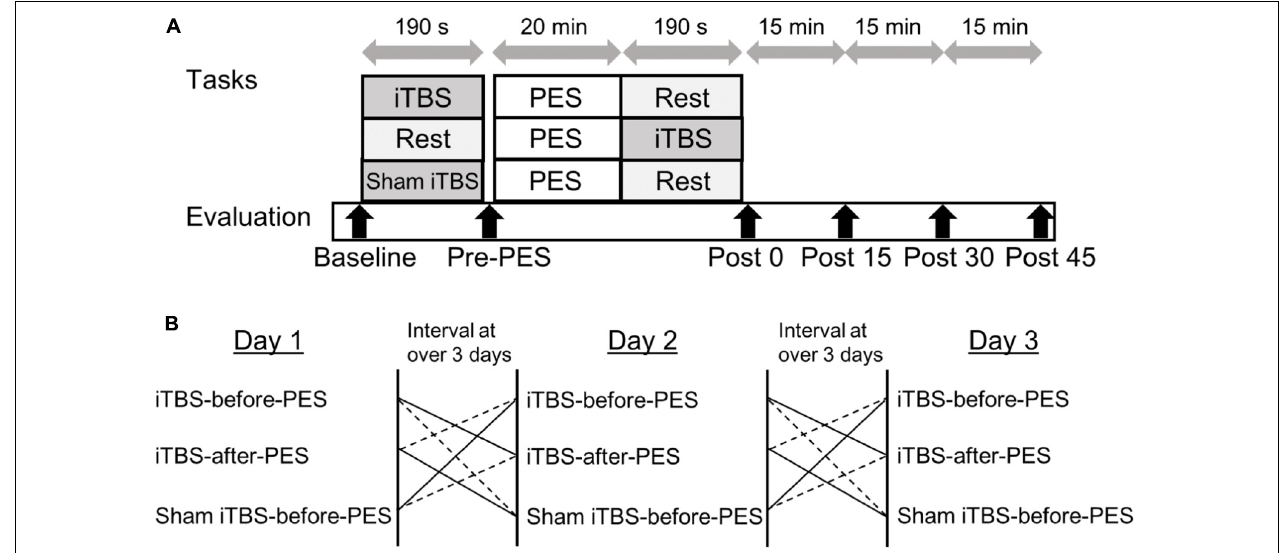
FIGURE 1 | Experimental paradigm for intermittent theta burst stimulation (iTBS) before and after patterned electrical stimulation (PES). (A) Time course of the experiment. (B) Sequence of interventions.